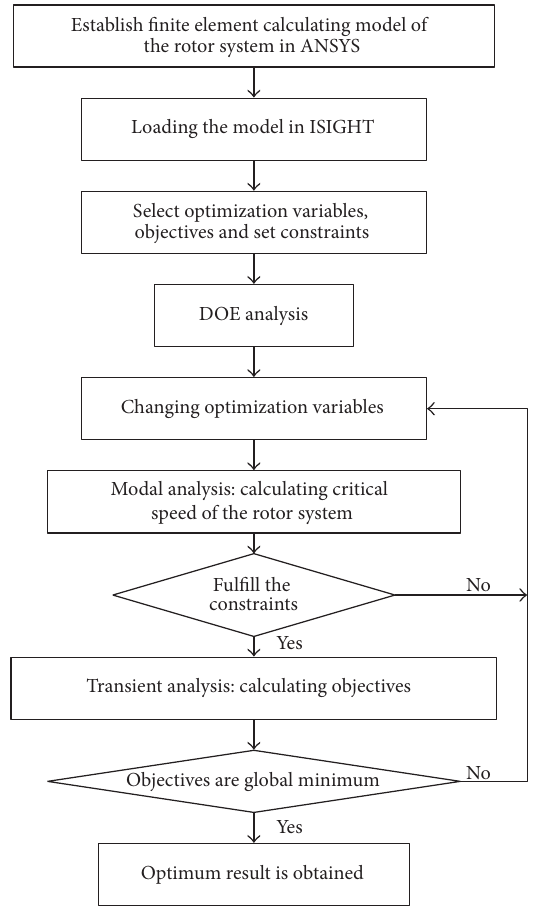
Figure 1: Flow chart of the optimization